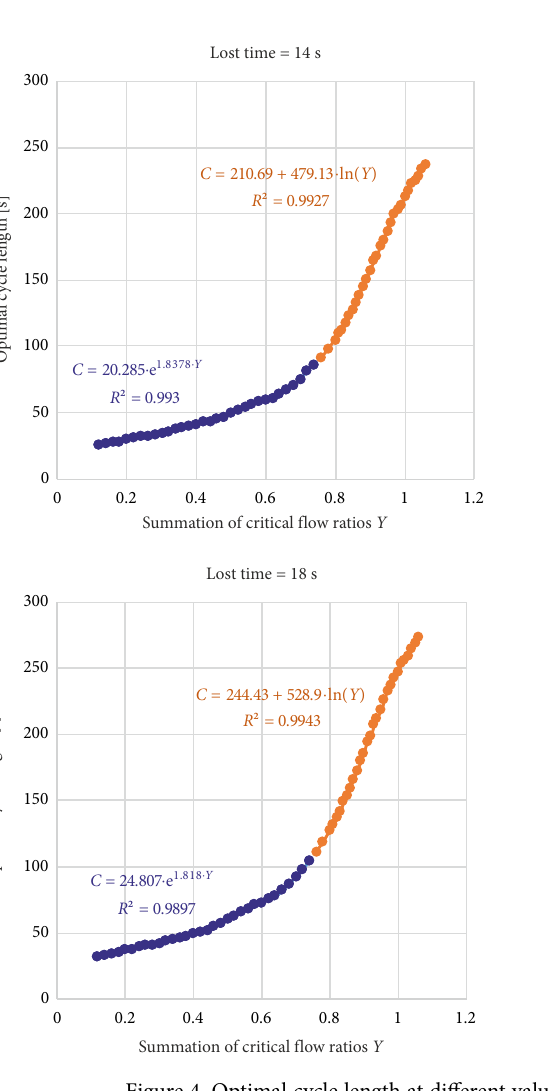
Figure 4. Optimal cycle length at different values of Y for lost times between 14 and 20